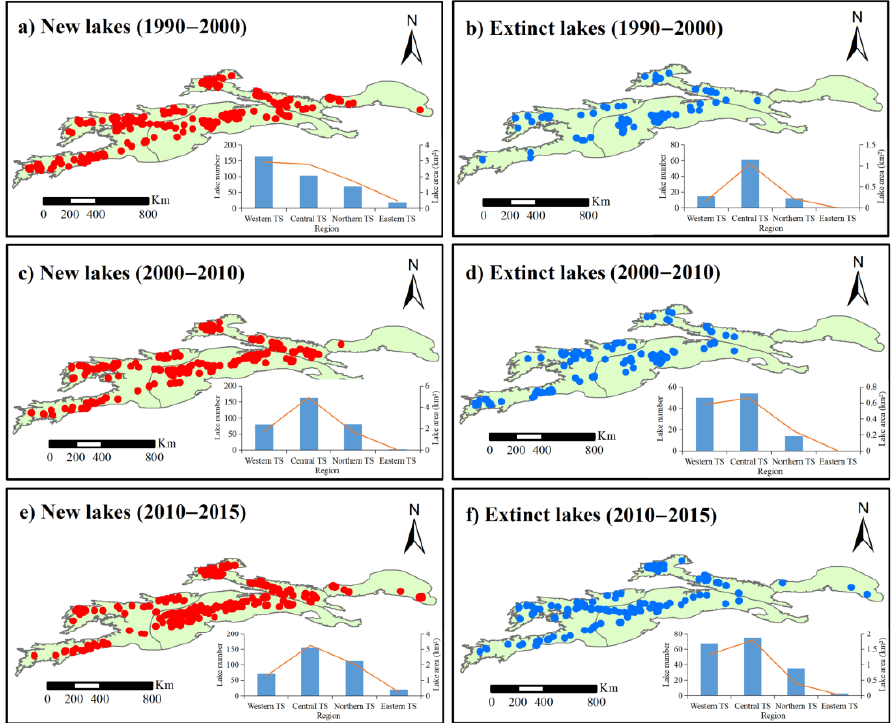
Figure 7. Changes in glacial lakes in the TS from 1990 to 2015. ( a , c , e ) Newly formed lakes between